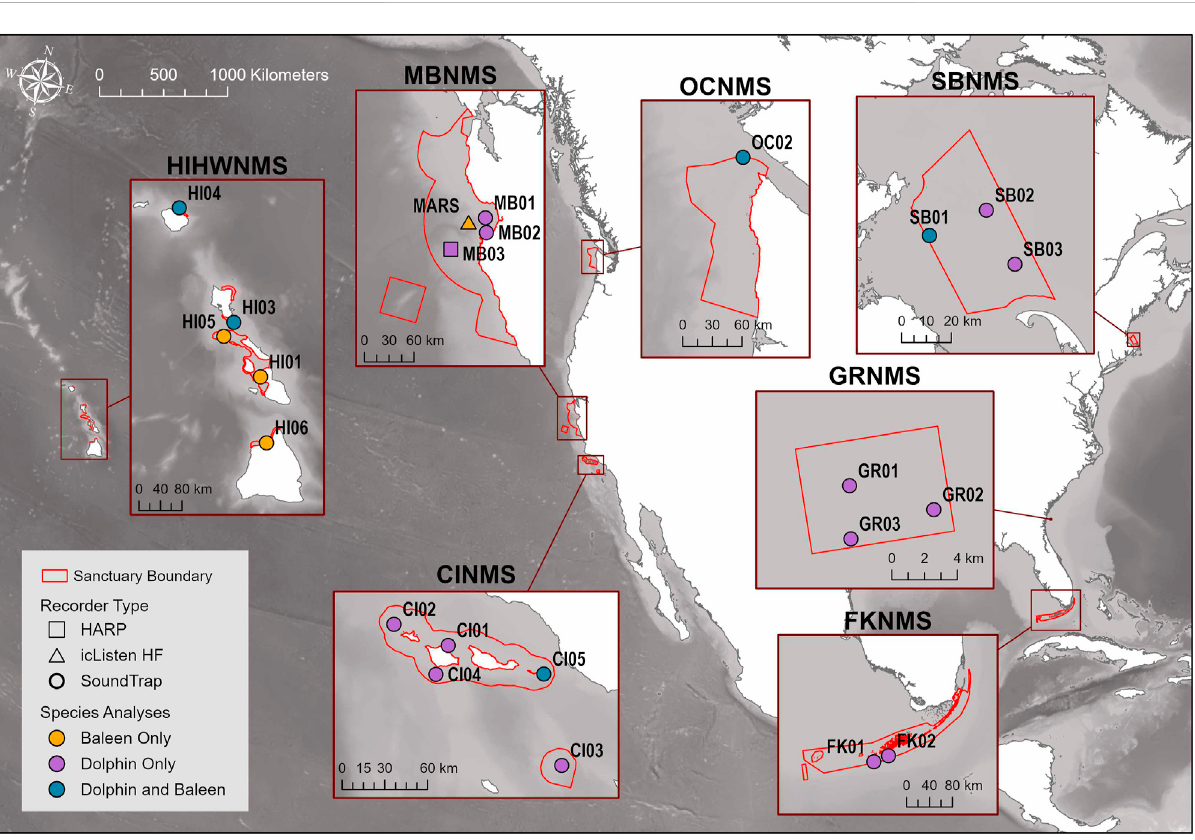
FIGURE 1 Map of the sites where passive acoustic recorders used in this study were stationed across seven NMS, divided into three main regions: East CoastRegionUnitedStates(US)-StellwagenBankNationalMarineSanctuary(SBNMS),Gray ’ sReefNationalMarineSanctuary(GRNMS),FloridaKeys National Marine Sanctuary (FKNMS); West Coast Region US - Olympic Coast National Marine Sanctuary (OCNMS), Monterey Bay National Marine Sanctuary (MBNMS), Channel Islands National Marine Sanctuary (CINMS) and Hawai ʻ i Region US - Hawaiian Islands Humpback Whale National Marine Sanctuary (HIHWNMS). Sites at each sanctuary are symbolized by both acoustic recorder instrument type and whether they were used for baleen whale and/or delphinid analyses. For the Hawaiian sites, the only baleen whale species that was analysed was humpback